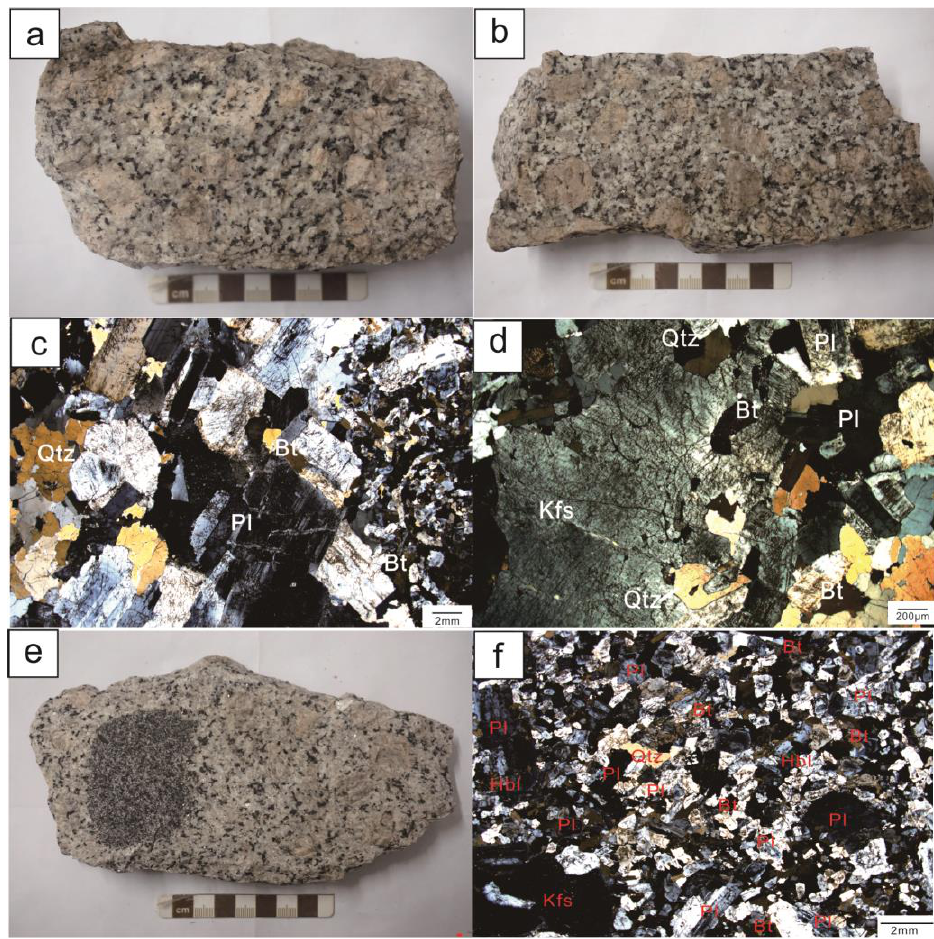
Figure 3. ( a , b ) Representative monzogranite samples for zircon LA-ICP-MS U-Pb dating and element analysis. ( c ) Euhedral to subhedral quartz, K-feldspar, plagioclase and biotite. ( d ) Subhedral K-feldspar with inclusions of biotite, plagioclase and quartz. ( e ) Representative fine-grained dark enclave sample for zircon LA-ICP-MS U-Pb dating and element analysis. ( f ) Fine-grained subhedral plagioclase, hornblende and quartz, K-feldspar and biotite. Mineral abbreviations: Pl: plagioclase, Qtz: quartz, Kfs: K-feldspar, Hbl: hornblende, Bt: biotite.